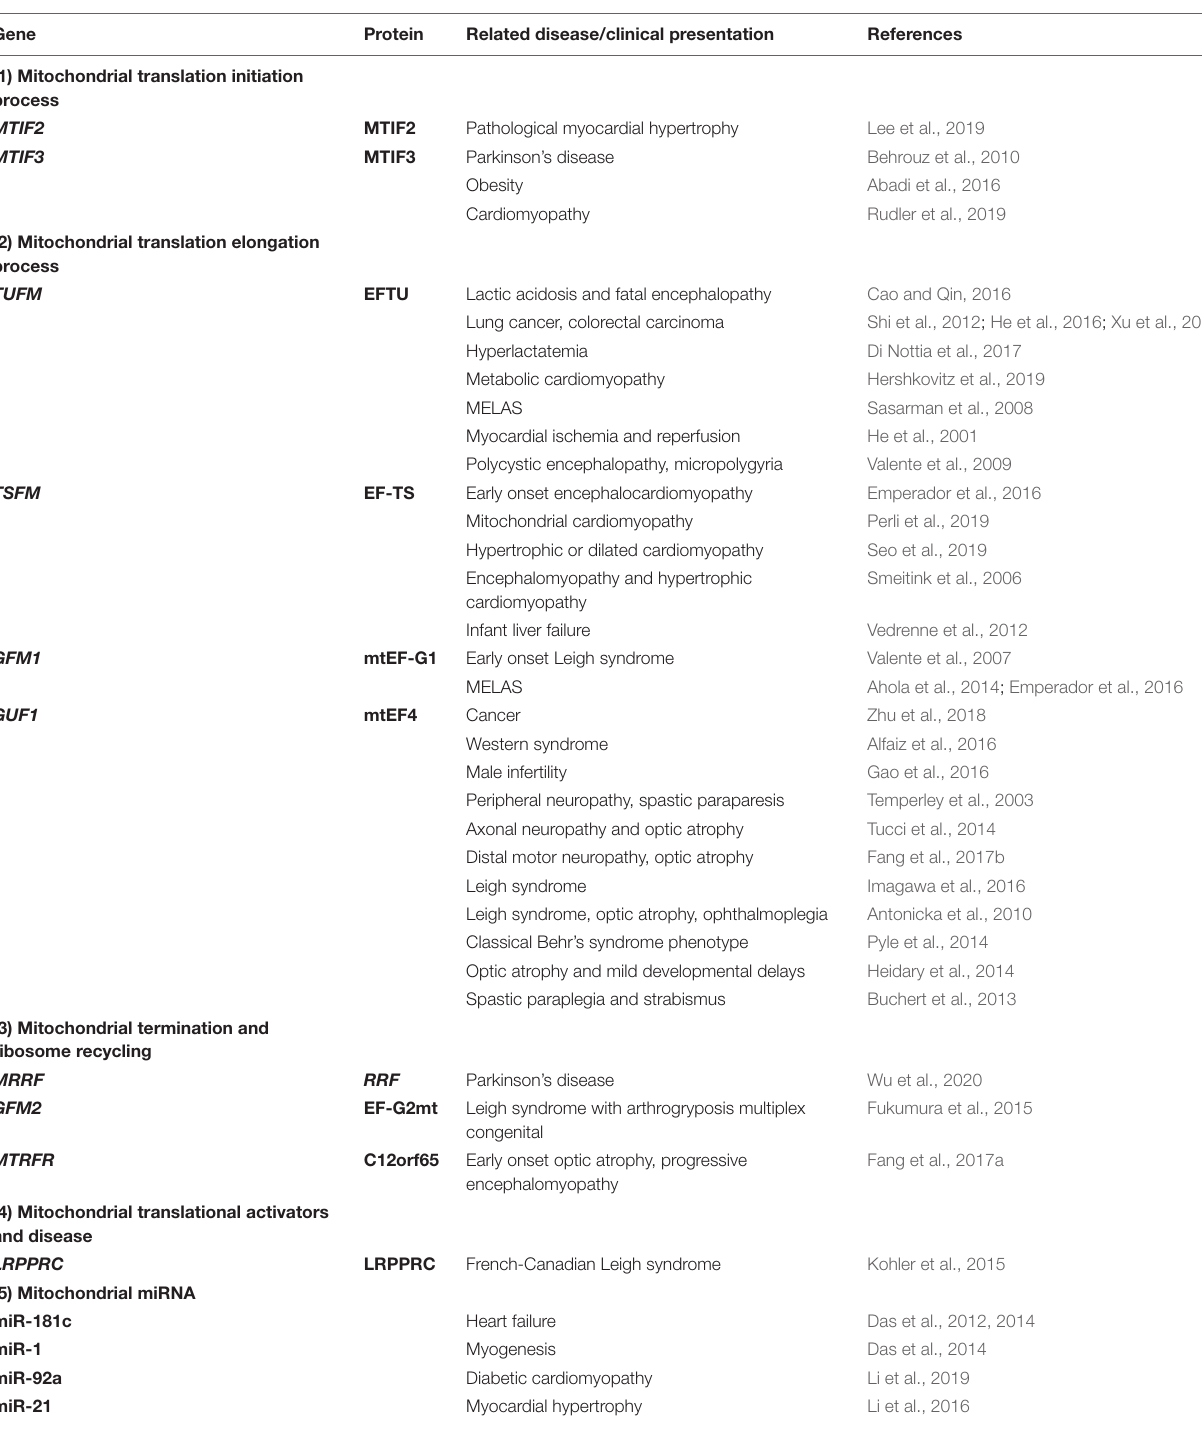
TABLE 1 | Mitochondrial translation factor mutations and related